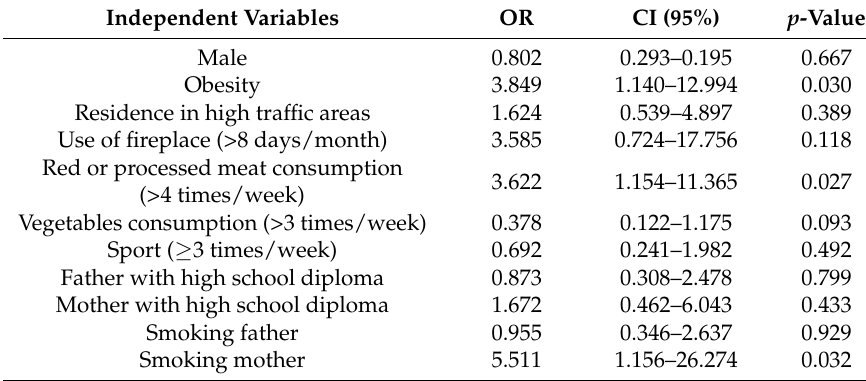
Table 8. Multivariate logistic regression analyses, with the corresponding odds ratio (OR) and a 95% confidence interval (CI), between personal or behavioral factors (independent variables) and positivity for the BMCyt assay (dependent variable). Independent Variables OR CI (95%) p -Value